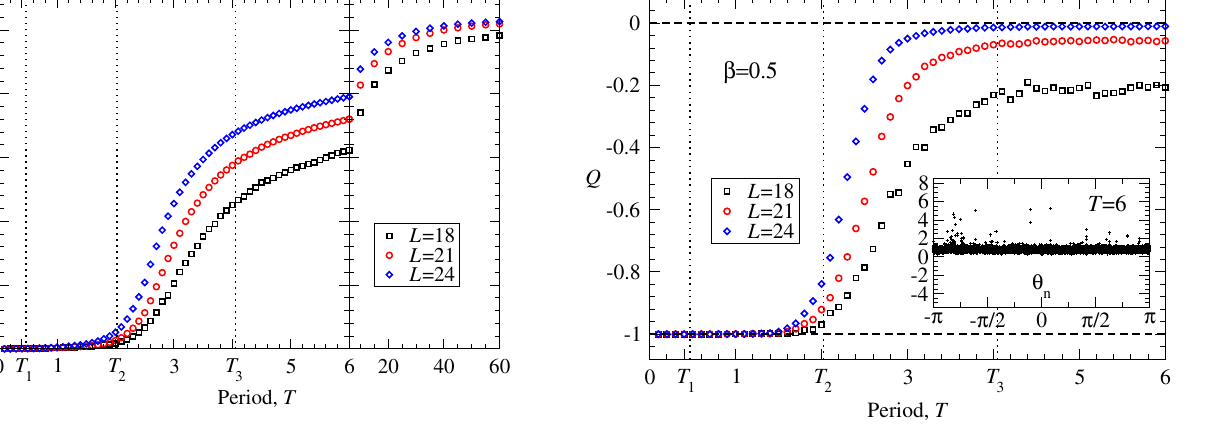
FIG. 5. Absorbed energy. (Main) Absorbed energy at long (infinite in our calculation) times Q [see Eq. (18)] vs the driving period T . The initial state is a thermal state (with respect to with β ¼ 0 . 5 . (Inset) Expectation values h ϕ n j exact phases θ n for L ¼ 24 and T ¼ 6